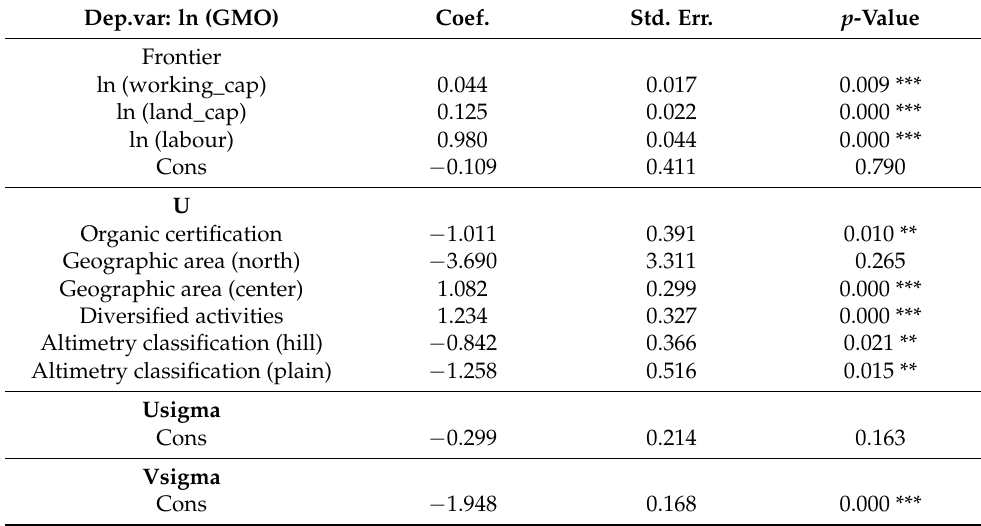
Table 3. Coefficient estimates of the stochastic frontier analysis. Dep.var: ln (GMO)